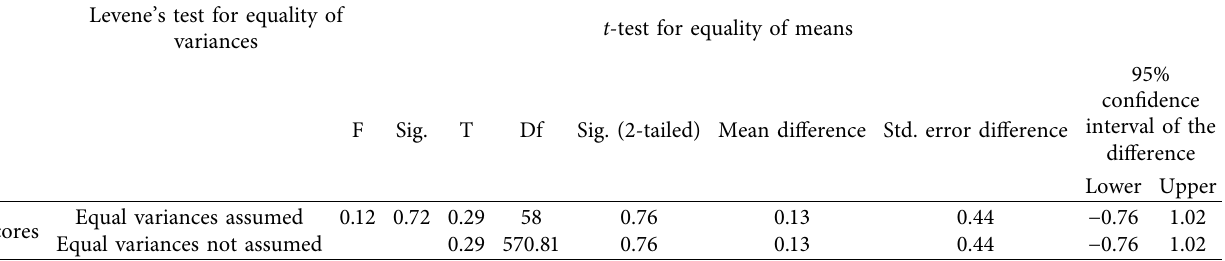
Table 12: Inferential statistics of the experimental and control groups in the speaking pretests. Levene’s test for equality